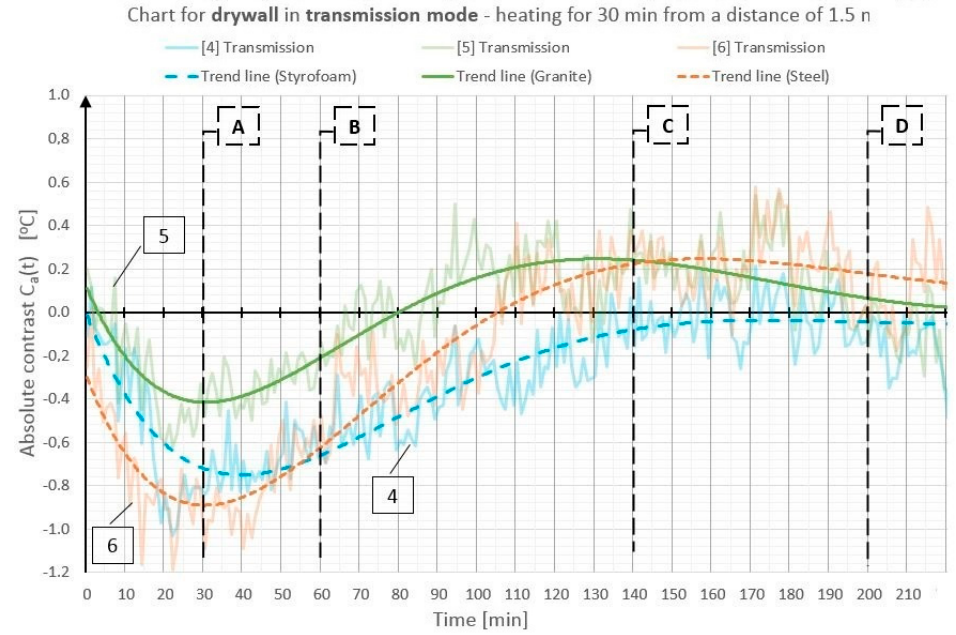
Figure 6. Diagram of absolute contrast for measuring in the transmission mode for the GB partition model with heating from a distance of 1.5 m (based on thermograms in Figure 3, row III).